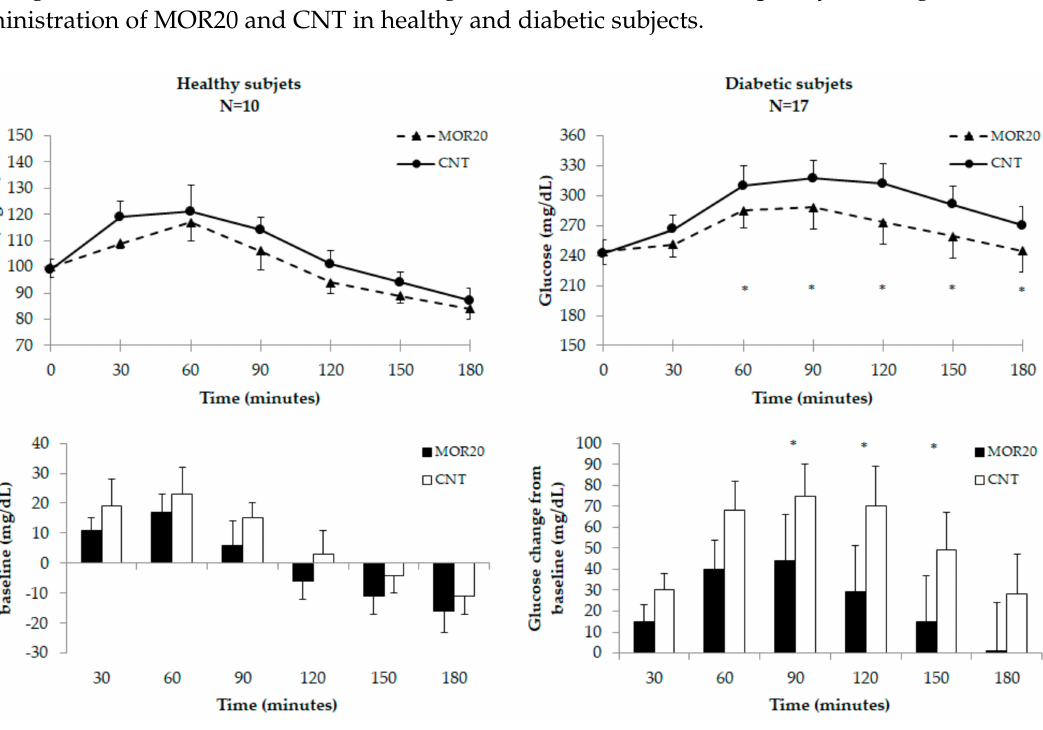
Figure 3. Kinetics and changes from the baseline of capillary blood glucose after administration of a meal with added 20 g of MO leaf powder (MOR20) and a control meal (CNT) in healthy and diabetic subjects. Values are reported in the graphs are means and standard errors. * p <